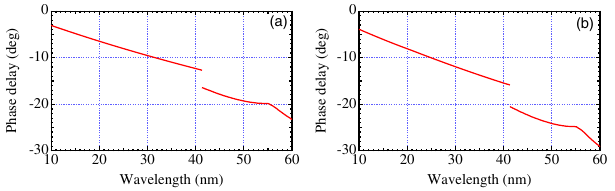
FIG. 4. Simulated phase delay between horizontal and vertical polarization versus wavelength for the optical transport system to DiProI (a) and LDM (b). See Fig. 3 for the step at ≈ 41 . 3